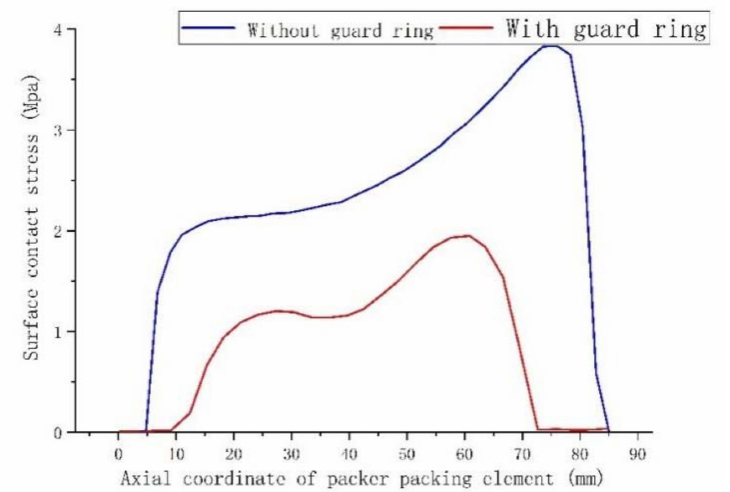
Figure 7. Comparison of contact stress and compression under F = 40 KN setting-down force.